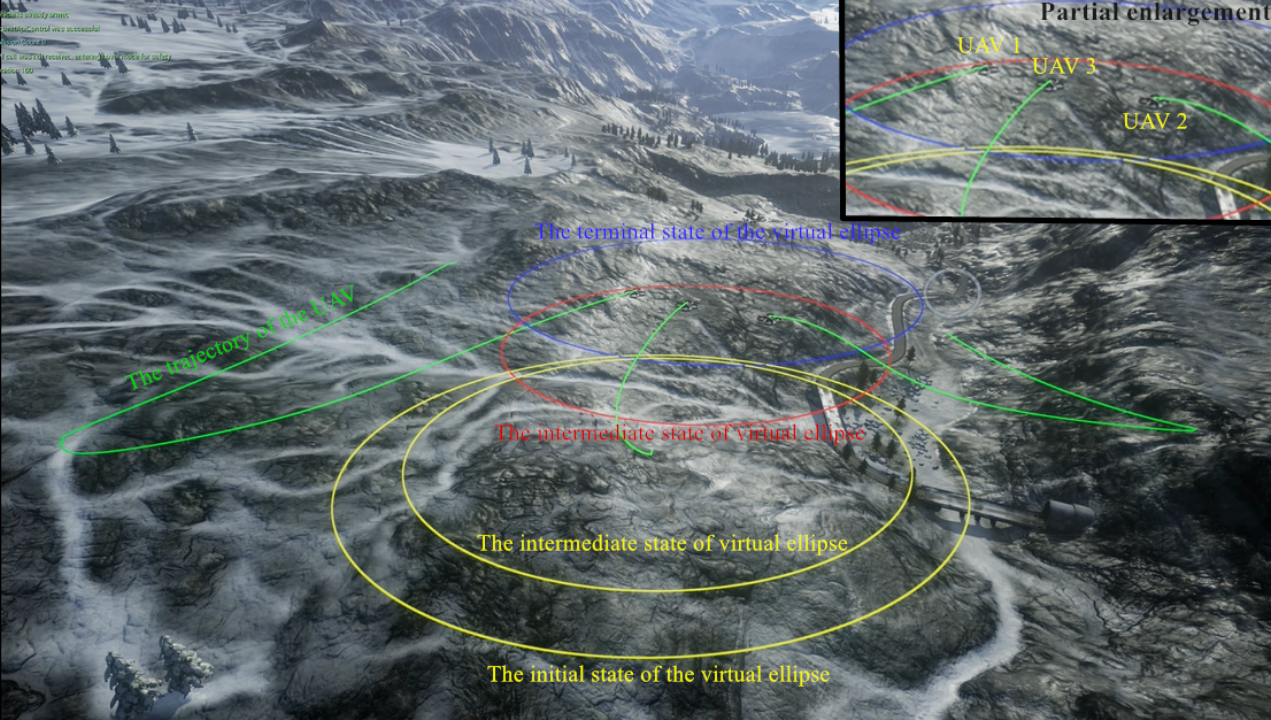
Figure 6. The movement of the UAV swarm corresponding to Figure